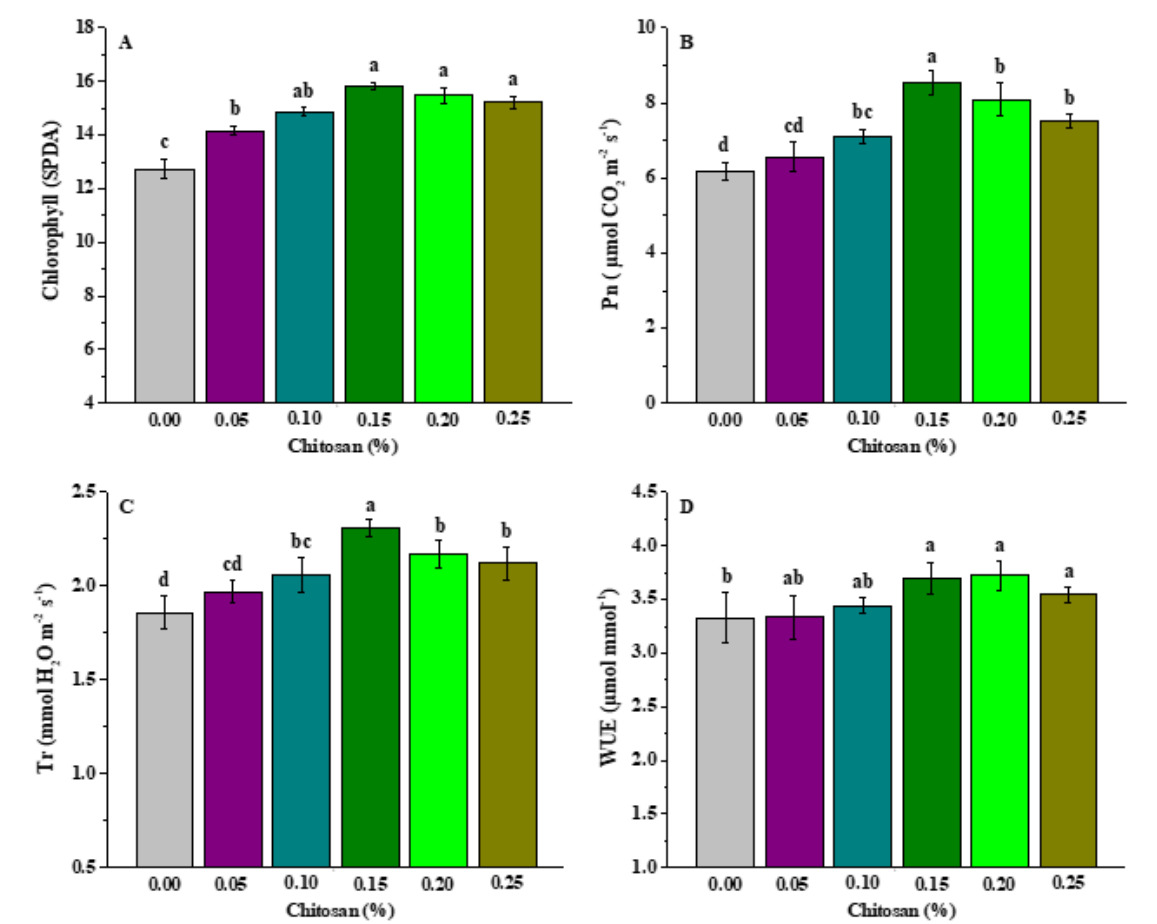
Figure 1. Influences of chitosan soaking on chlorophyll ( A ), Pn ( B ), Tr ( C ), and WUE ( D ) of P. grandiflorus leaves. The SD of three replicates was indicated by error bar. A one-way analysis of variance (ANOVA) followed by Duncan’s test was used, and the significant differences at a 5% level ( p < 0.05) in the six treatments are represented by different letters.